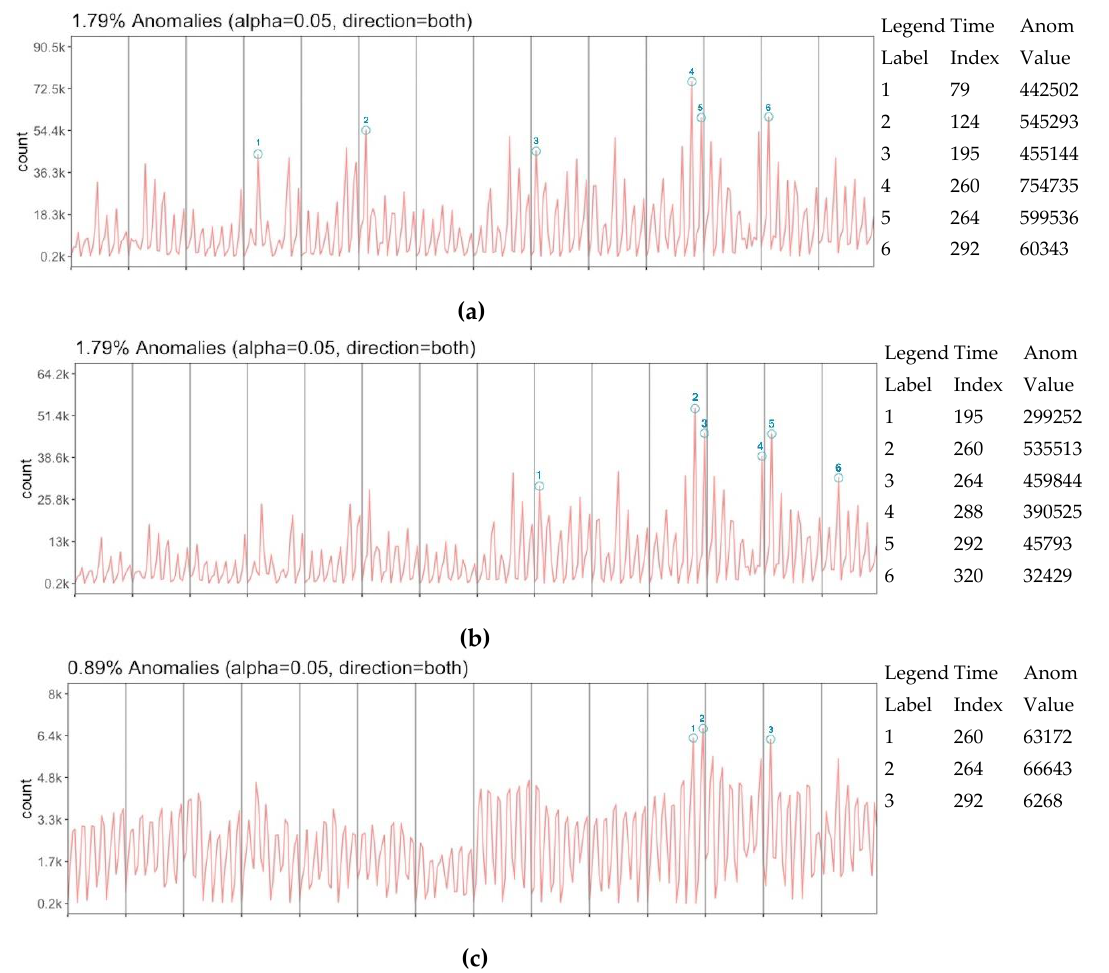
Figure 10. Anomaly in (a) number of tweets; (b) number of users; (c) normalized number of tweets.